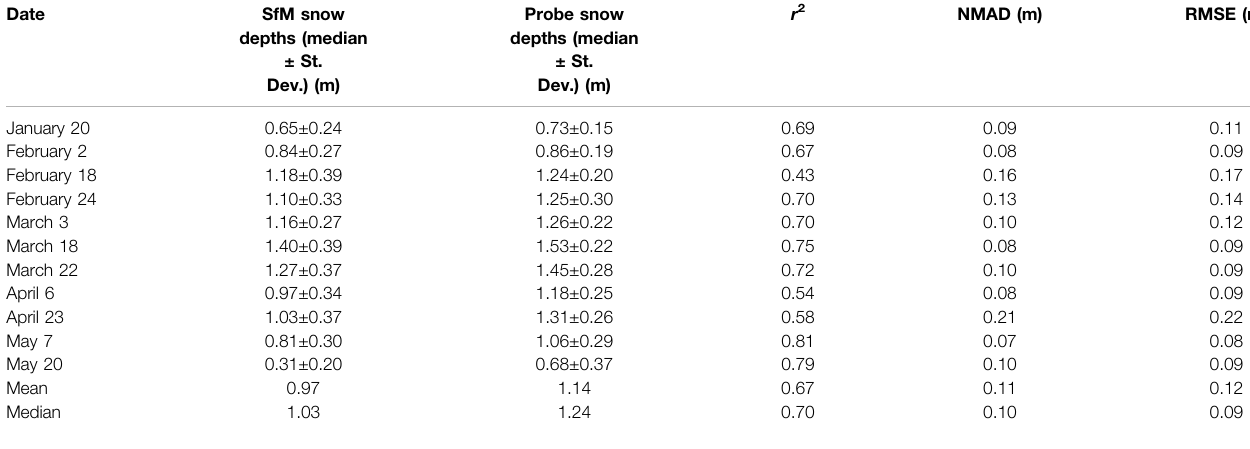
TABLE 2 | SfM snow depths (over entire study plot) and probe snow depths (along survey line) and results from statistical comparison. r 2 NMAD (m) RMSE Date SfM snow Probe snow depths (median depths (median ± St. ± St. Dev.) (m) Dev.) (m)